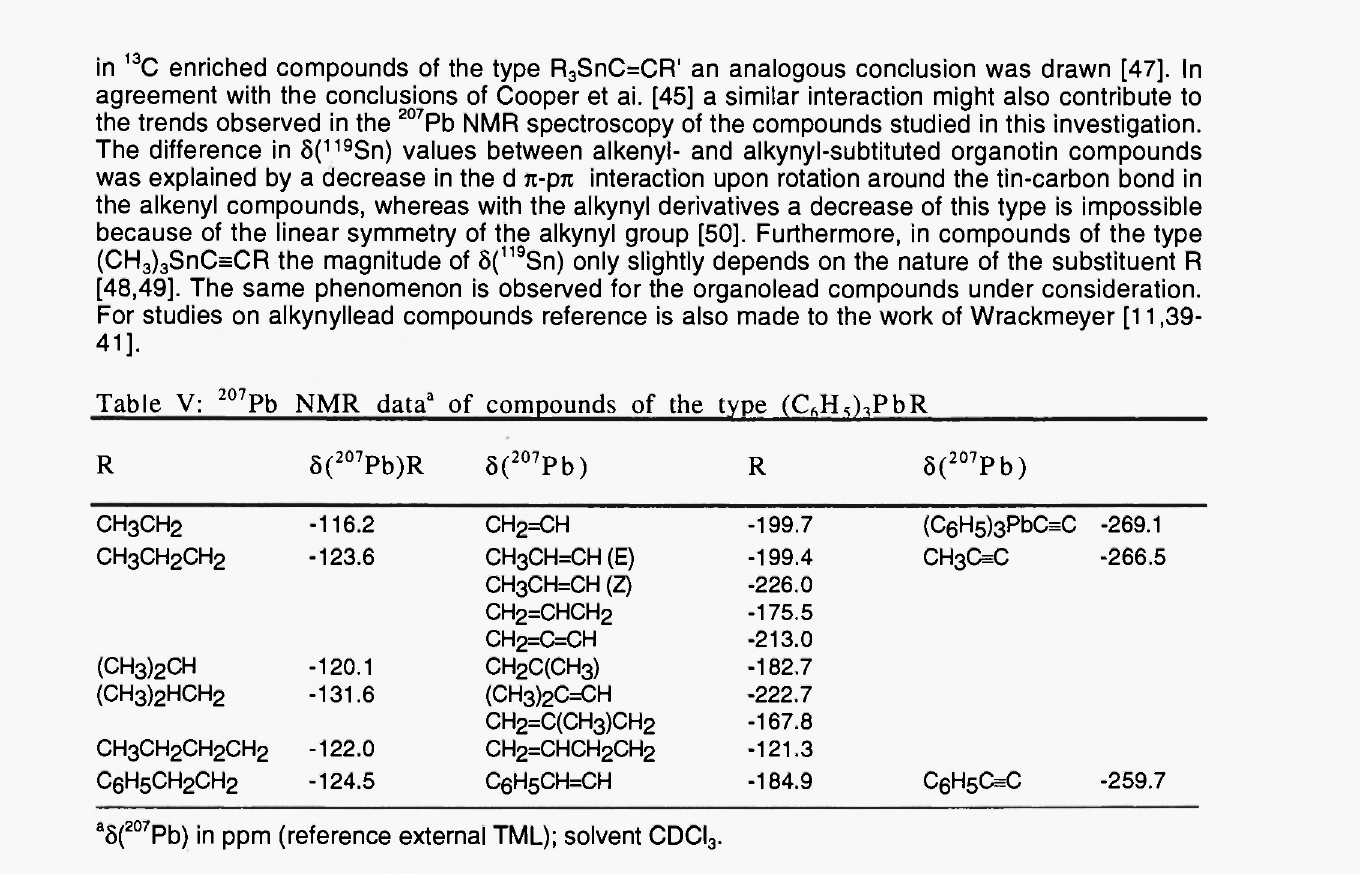
Table V: 207 Pb NMR data" of compounds of the type (C